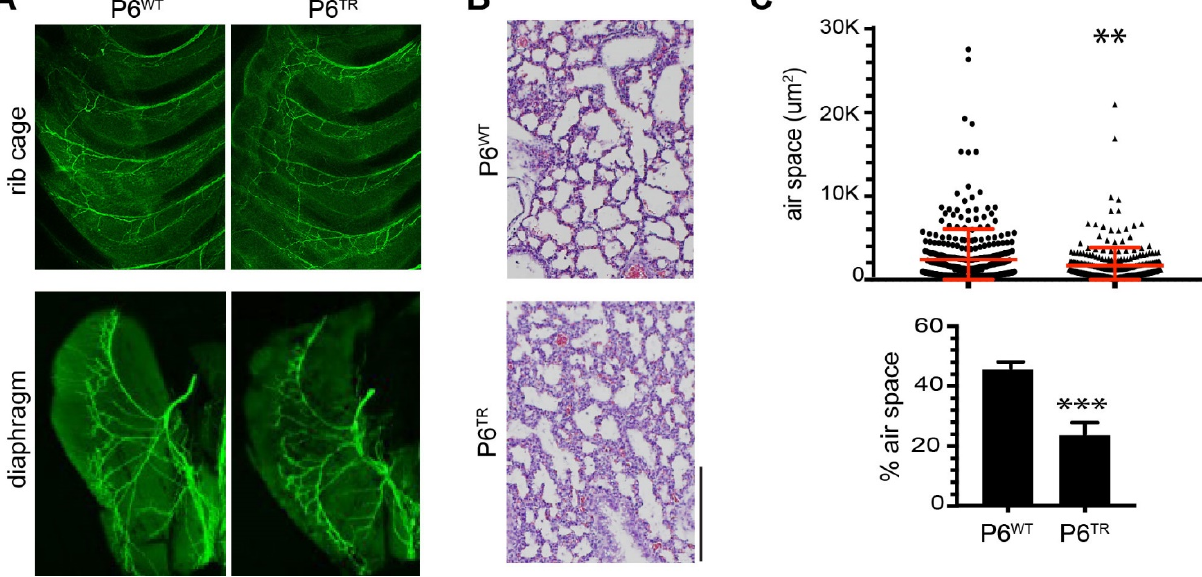
Figure 5. Innervation of rib cage and diaphragm of Parp6 TR is indistinguishable from Parp6 WT newborns, while Parp6 TR animals show less air in their lungs after 60 min of being born. ( A ) Representative images of rib cages (top) and diaphragms (bottom) of E18 Parp6 WT and Parp6 TR labeled with β -tubulin showing their innervation patterns (top). ( B ) Lung sections of Parp6 WT and Parp6 TR newborns (under 60 min old) stained with H&E showing size and proportion of open alveolar spaces (air, top). Scale bar = 25 µ m. ( C ) Representative distribution of individual alveolar air spaces ( µ m 2 ), showing that individual air spaces are significantly fewer and smaller in Parp6 TR compared to Parp6 WT ( t -test p = 0.0029, **). ( D ) Percentage of total alveolar space of Parp6 WT vs. Parp6 TR ( t -test p < 0.0001, ***). n = 389 and 288 for Parp6 WT and Parp6 TR , respectively (bottom). n = 4 images for each